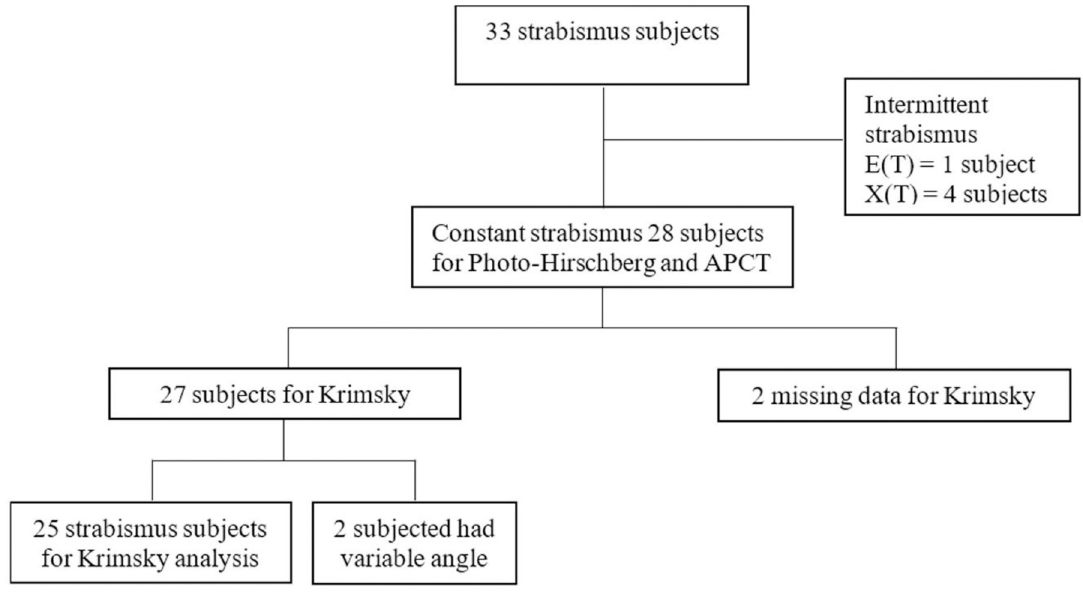
Fig 2. Flow diagram of strabismus